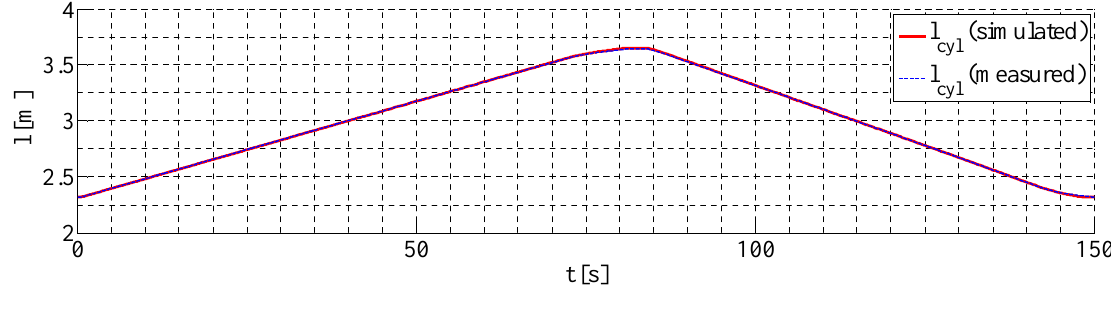
Figure 17: Measured and simulated cylinder